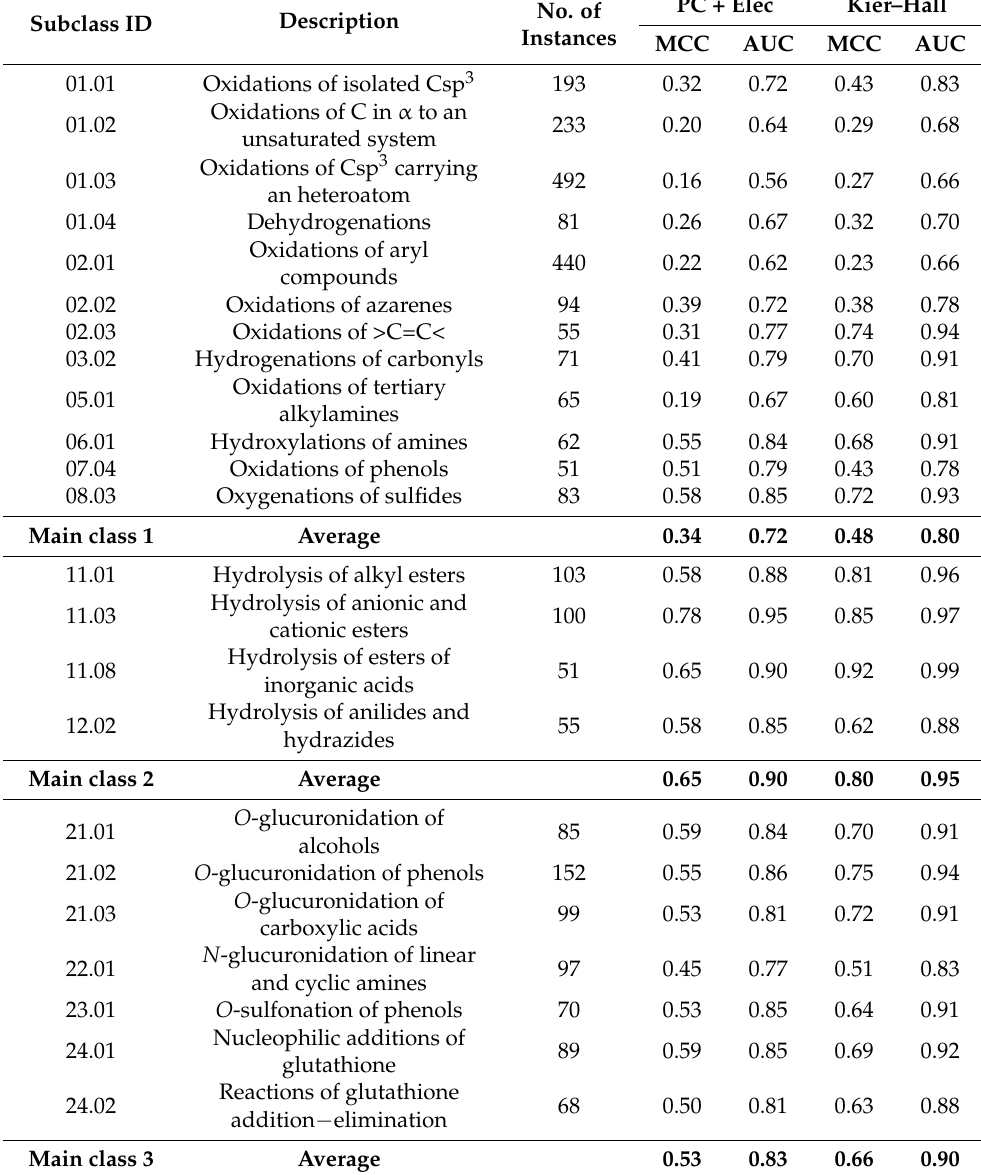
Table 4. Performance of the predictive models for the subclasses of metabolic reactions with at least 50 substrates based on US balanced datasets and exploiting two sets of descriptors (physicochemical plus stereo-electronic descriptors and Kier–Hall topological indices). Only overall performance metrics are